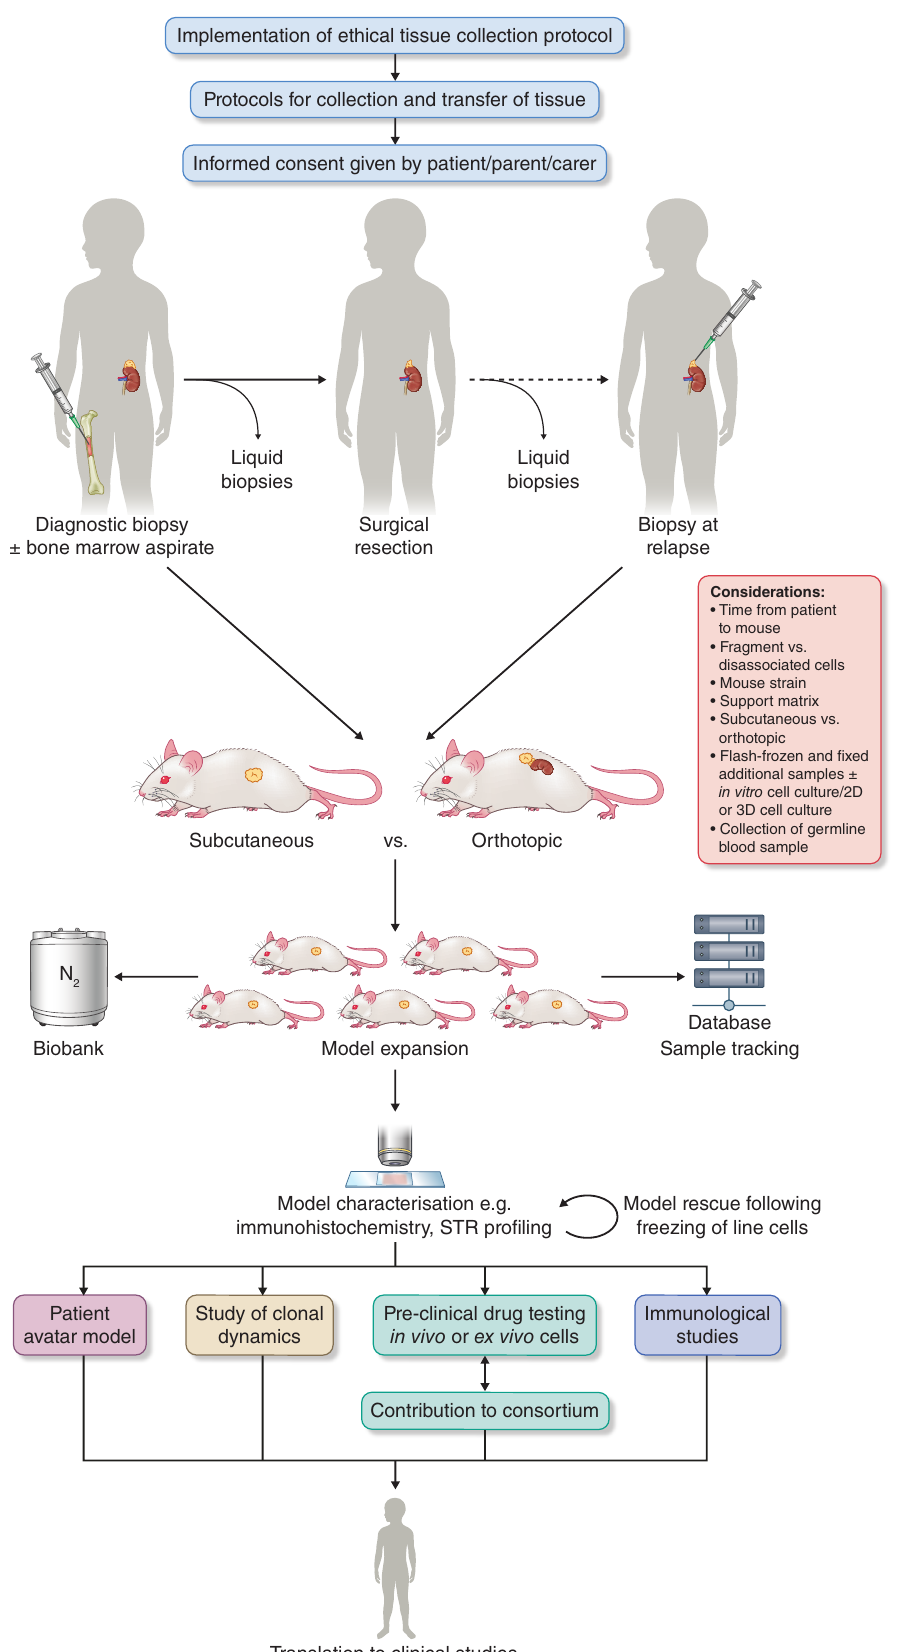
Figure 1. Generalised schematic for the implementation, establishment and potential use of a neuroblastoma PDX biobank. The initial step is to gain local or national ethical approval for a patient tissue collection study, with strong links to